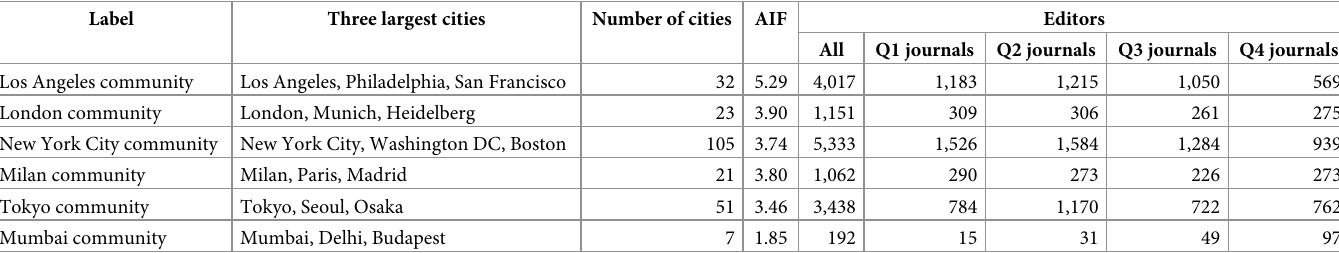
Table 3. Communities of core